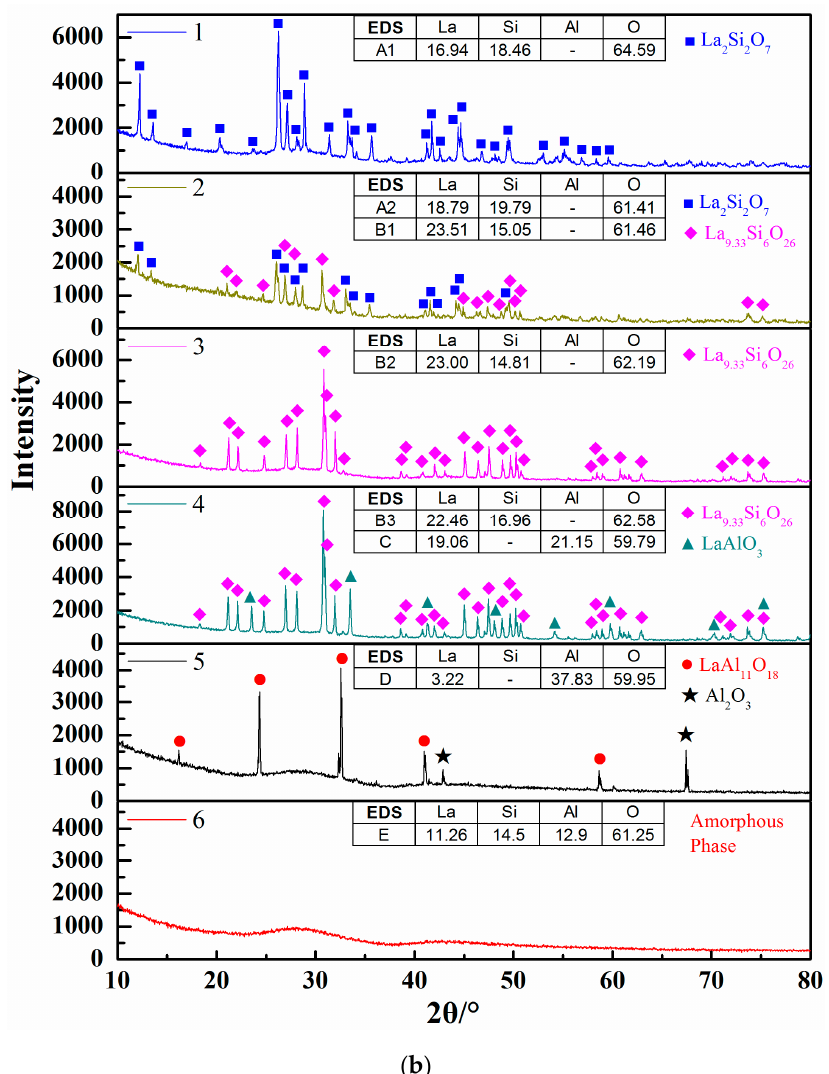
Figure 5. Morphology and component analysis of phases formed at 1500 °C. ( a ) SEM images of phases formed at 1500 ℃ ; ( b ) XRD patterns of phases formed at 1500 ℃ , 1–6 represent the XRD patterns of experimental points 1-6 marked in Figure 4b, respectively.